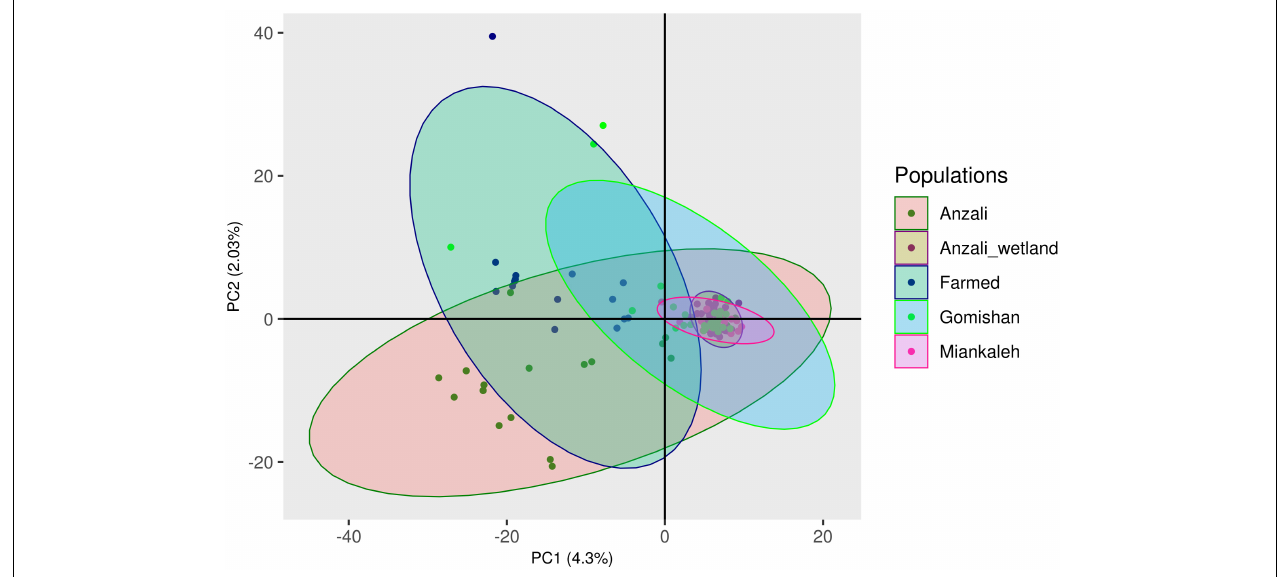
FIGURE 2 | Principal component analysis (PCA) scatter plot based on 17,828 GBS-obtained SNPs on investigated populations of C. carpio . TABLE 1 | Fst values between different locations of C. carpio based on 17,828 SNP markers. Anzali Anzali-wetland Miankaleh Gomishan Farmed Anzali 0.000 Anzali-wetland 0.043 0.000 Miankaleh 0.051 0.023 0.000